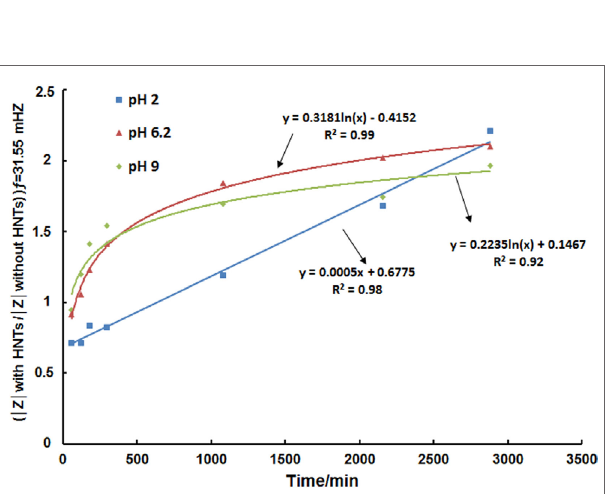
FigUre 7 | curves of the kinetics of the release of encapsulated dodecylamine inhibitor from halloysite for different immersion times in 0.1 mol/l nacl solution at different ph values